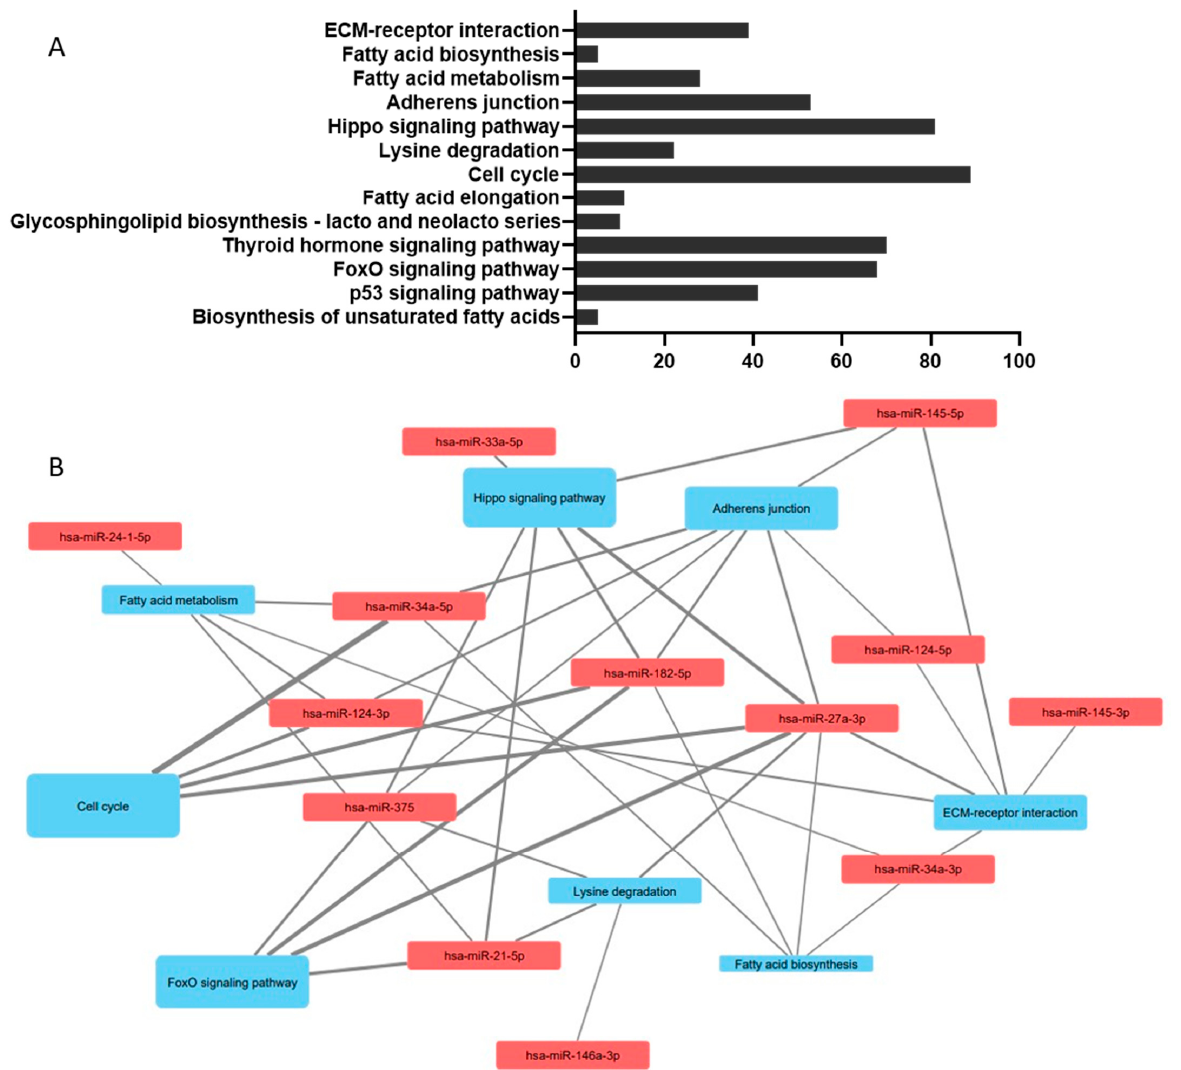
Figure 3. ( A ) The KEGG pathways identified through miRPath v3.0 strongly associated with miRNAs involved in lipid metabolism in pancreatic beta cells. All miRNAs included in the analysis were conserved between species with two caveats: mature rno-miR-182 shares 95% sequence similarity with hsa-miR-182-5p and mmu-miR-297b-5p shares 71% sequence similarity with mature hsa-miR-297b. Disease-specific pathways were excluded from the results. Pathways are ranked in order of the most closely linked pathways. ( B ) Interaction network between miRNAs involved in lipid metabolism in pancreatic beta cells mapped in Cytoscape v3.8.0. The network is annotated so that the size of the pathways labels is proportional to the number of genes in the network associated with the relevant miRNAs and the thickness of the edges shows the contribution of that miRNA as a proportion of the total miRNA–gene interactions in each pathway. Pathways associated with <4 miRNAs were excluded from the analysis to improve clarity of the map.